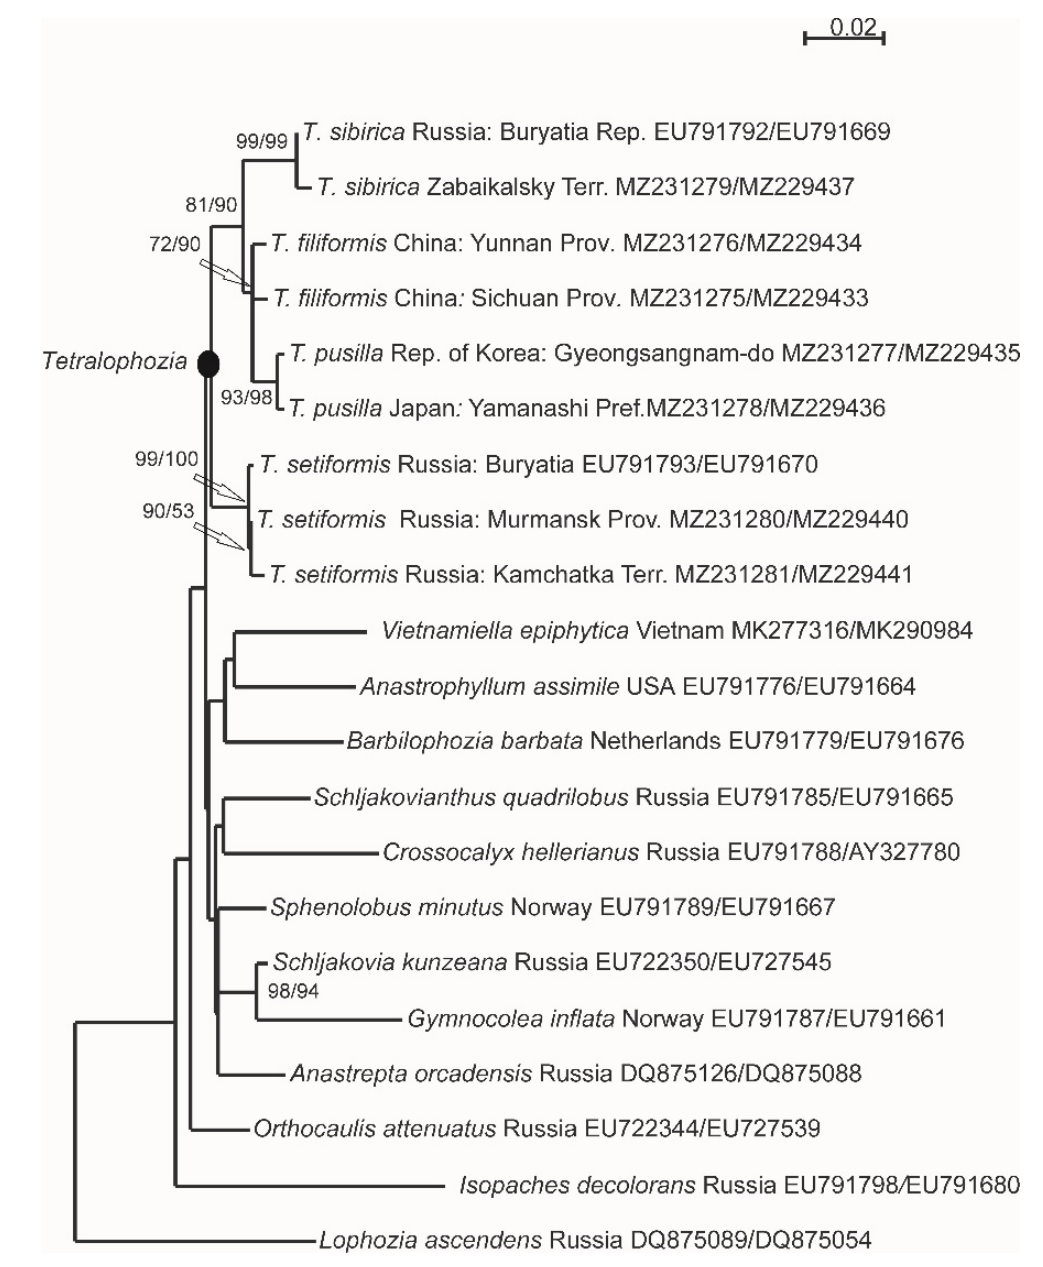
Figure 1. The phylogenetic tree resulted from ML analysis of the combined dataset ITS1–2 + trn L–F for the family Anastrophyllaceae. Bootstrap support values ≥ 50% of maximum parsimony and maximum likelihood analyses are indicated. GenBank accession numbers ITS1–2/ trn L–F are shown. Table 1. The value of p -distances for the genus Tetralophozia .